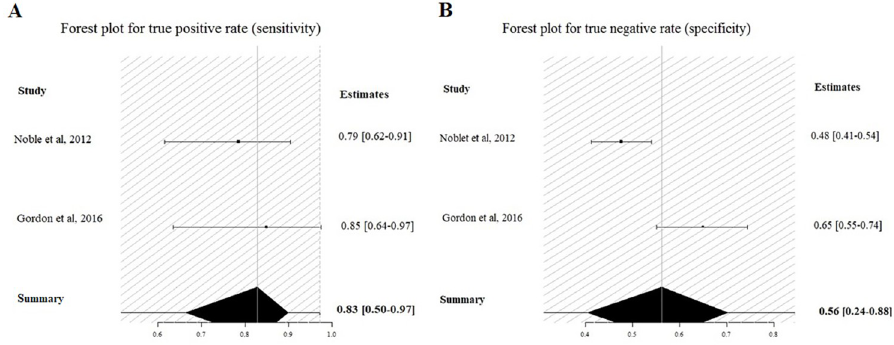
Fig 6. Forrest plot for POD4: Estimated pooled sensibility (A) and specificity